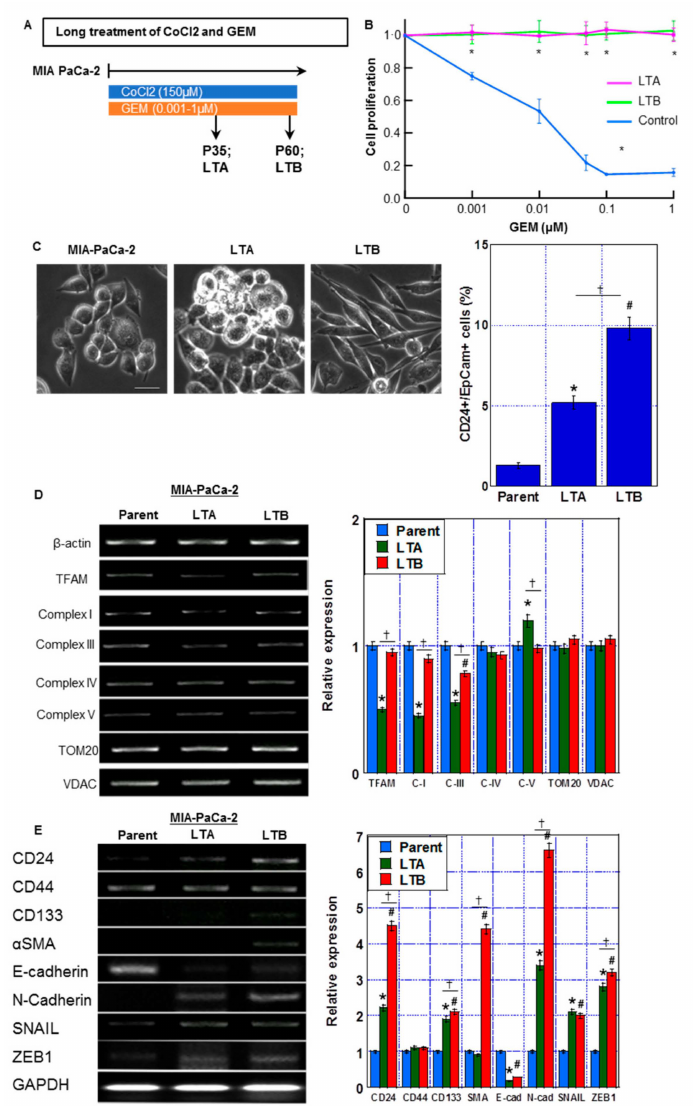
ated with marked stratification and LTB cells showed spindle morphology. In LTA and LTB cells, CD24+/EpCam+ cell population was increased.